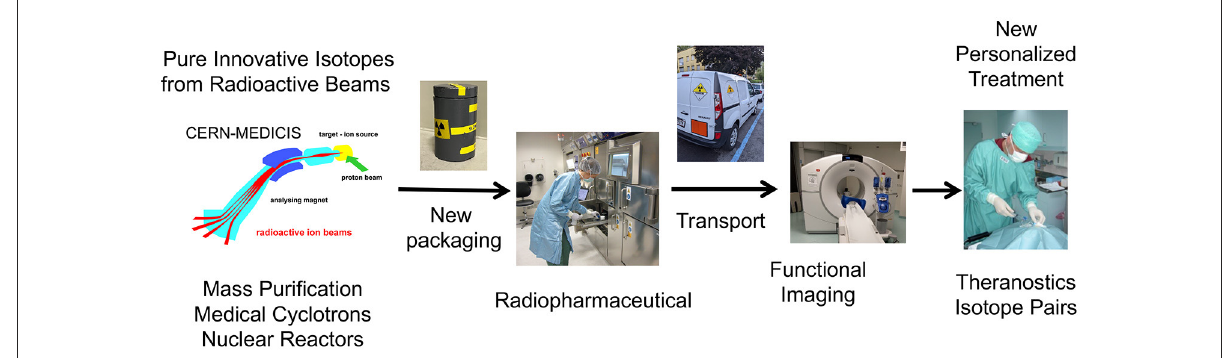
FIGURE1 MEDICIS-Promed overview of innovative treatments based on radioactive ion beams: from production, transport to preclinical and clinical studies.